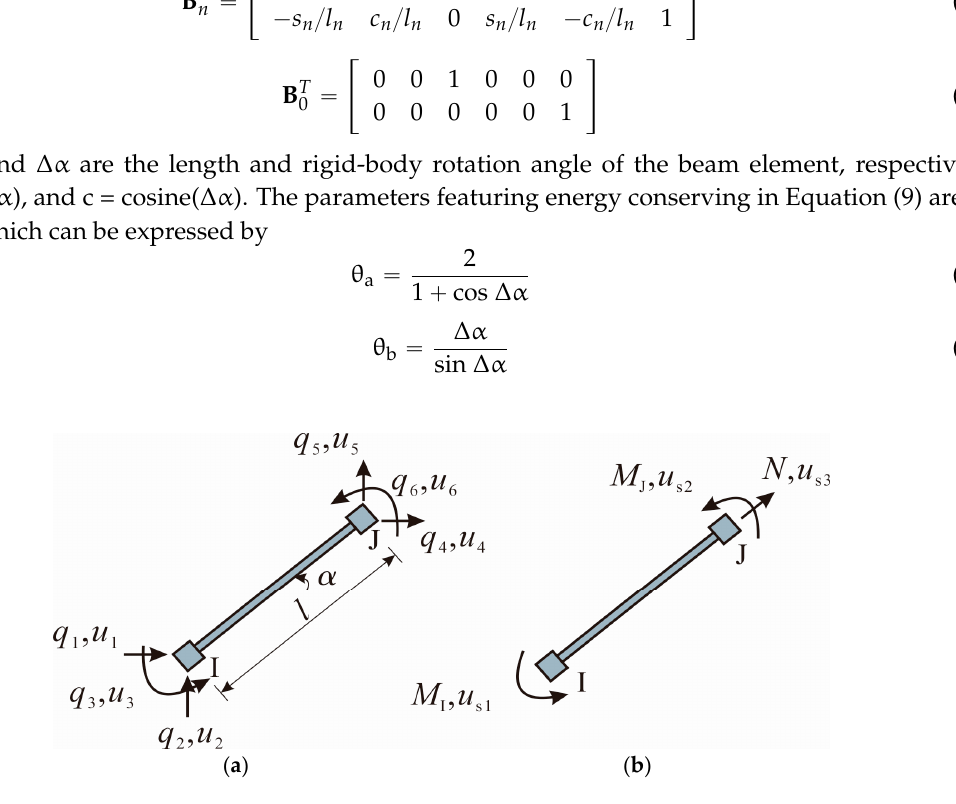
Figure 1. Beam element in different coordinate systems, ( a ) global system; ( b ) basic (simply supported) system.